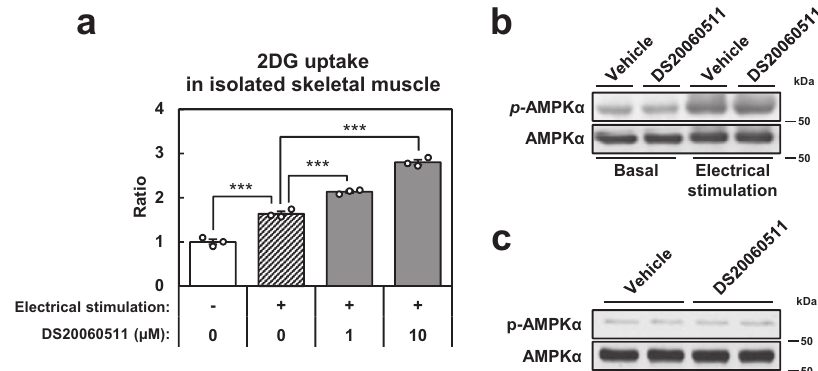
Fig. 6 DS20060511 increases glucose uptake without affecting AMPK phosphorylation. a Concentration-dependent DS20060511-stimulated 2-DG uptake with muscle contraction (5 Hz electrical stimulation) in isolated muscles from C57BL/6 mice ( n = 3). *** P < 0.001 by one-way ANOVA followed by Tukey ’ s test. b Muscle contraction (5 Hz electrical stimulation) induced AMPK (Thr172) phosphorylation with or without 10 μ M DS20060511 in isolated muscles from C57BL/6 mice. c Phosphorylation levels of AMPK α of the Triceps surae muscles excised from C57BL/6 mice (n = 2) treated with Fig.